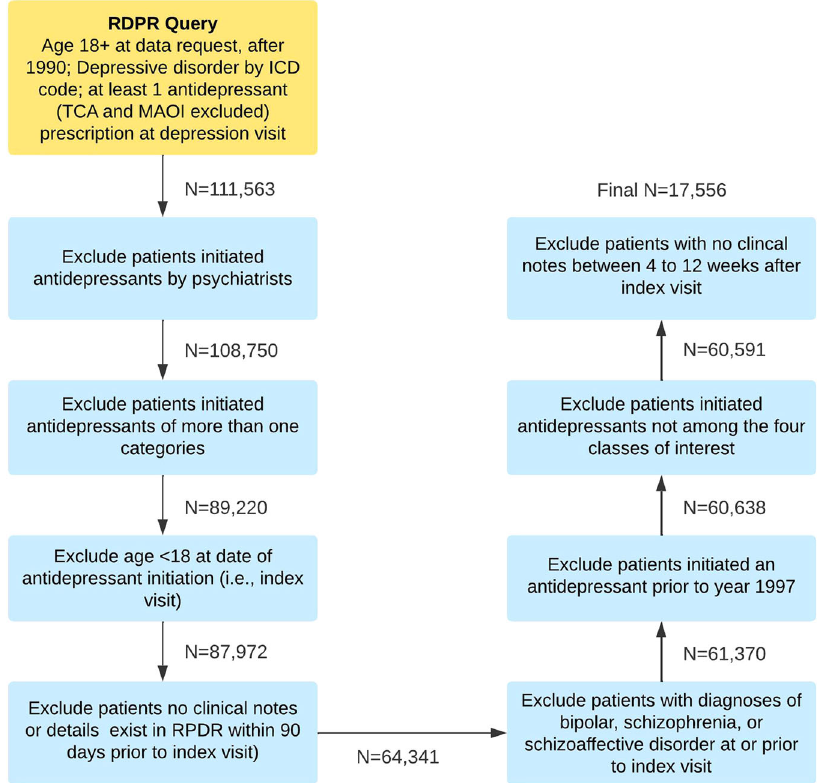
Fig. 1 Flowchart for sample selection after sequential application of exclusion criteria. Text boxes denote each step for sampleselection. The numbers next to the arrows represent the number of patients remaining after applying the selection step in the preceding text